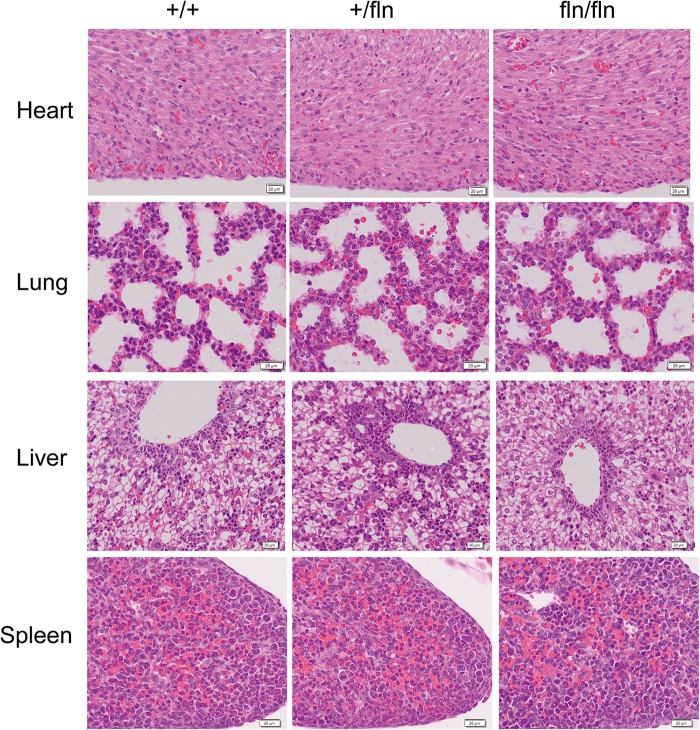
No obvious histological abnormalities were observed in heart, lung, liver, and spleen of homozygous. Representative sections of H&E staining on heart, lung, liver, and spleen samples from +/+ (n = 3), +/fln (n = 3), and fln/fln (n = 3) embryos at E18.5. Bar = 20 μm.